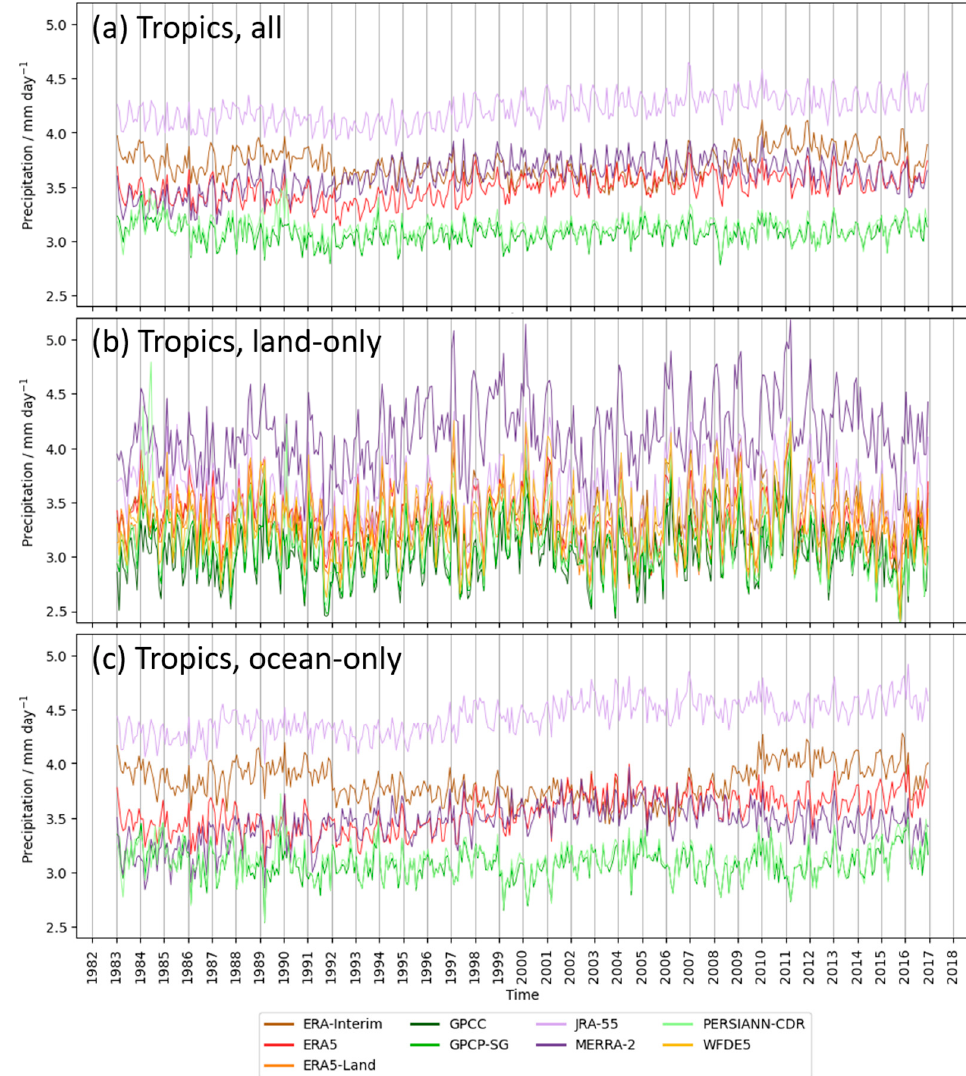
Figure 6. Time series of monthly mean precipitation rates averaged over the Tropics (30° S–30° N) for the period 1983–2016. ( a ) entire tropical region; ( b ) land ‐ only values in the tropical region (including ERA5 ‐ Land, GPCC and WFDE5 data); ( c ) ocean ‐ only values in the tropical region.